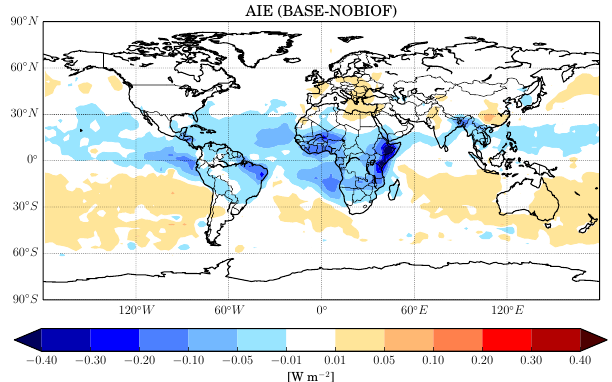
Figure 7. The cloud-albedo AIE for the BASE–NOBIOF compari- son (mean: − 0.006Wm − 2